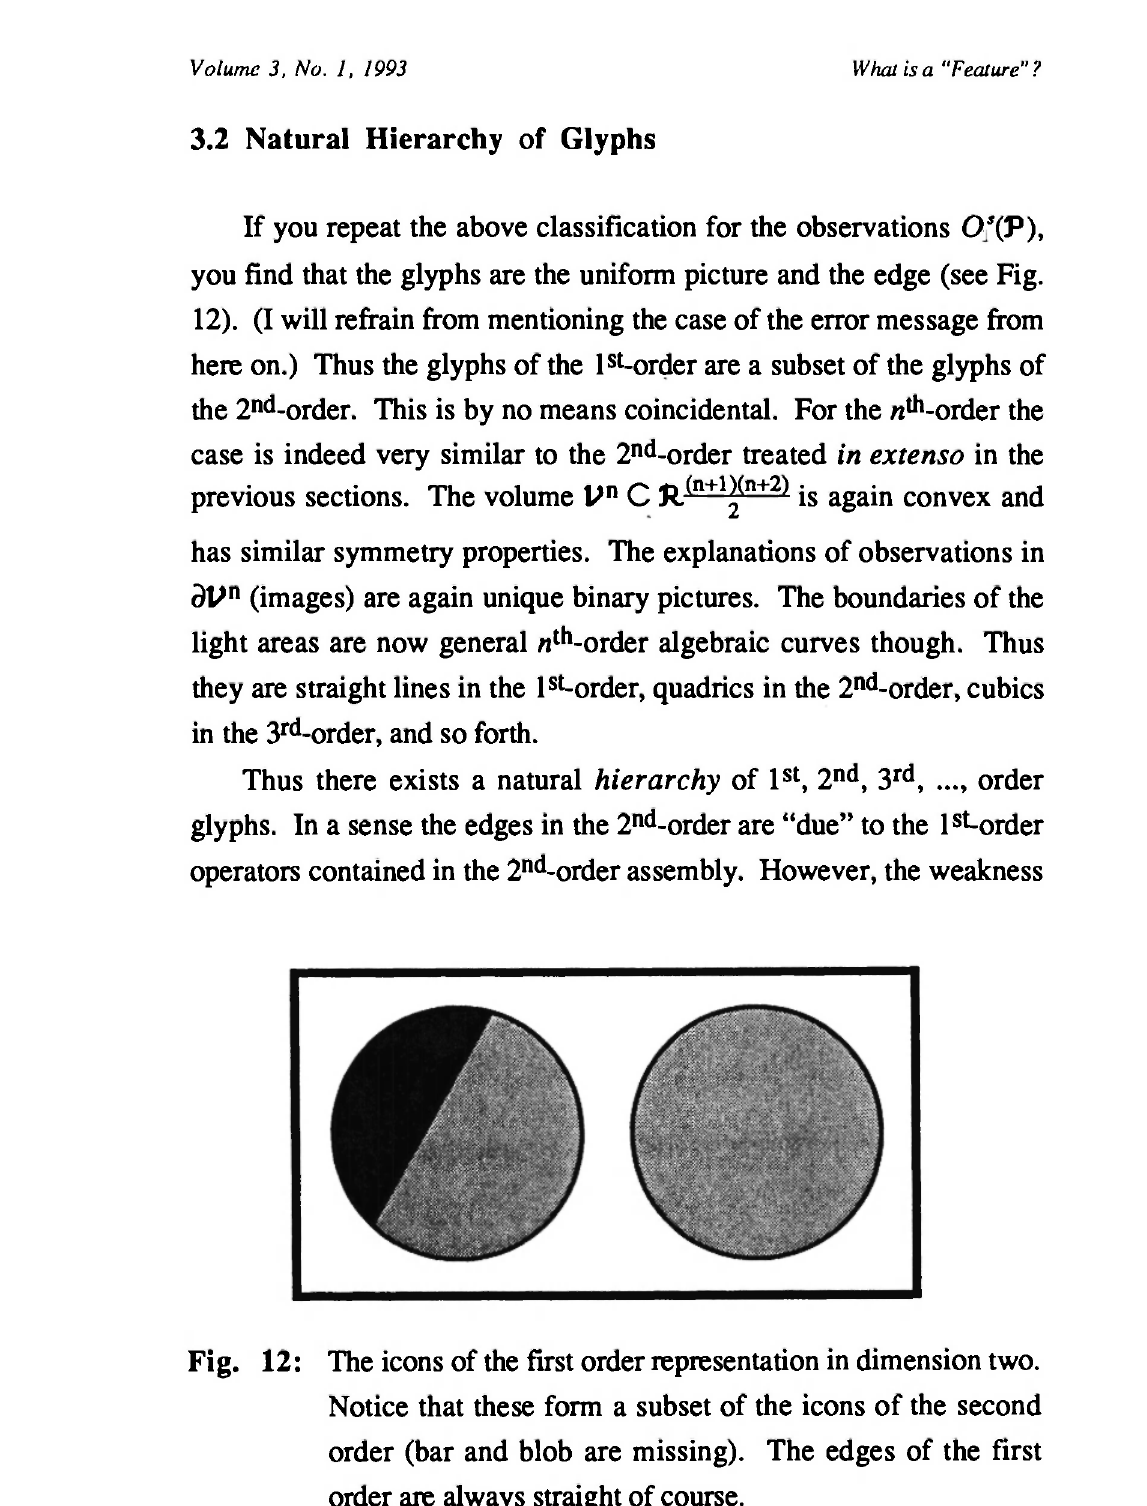
12: The icons of the first order representation in dimension two. Notice that these form a subset of the icons of the second order (bar and blob are missing). The edges of the first order are always straight of